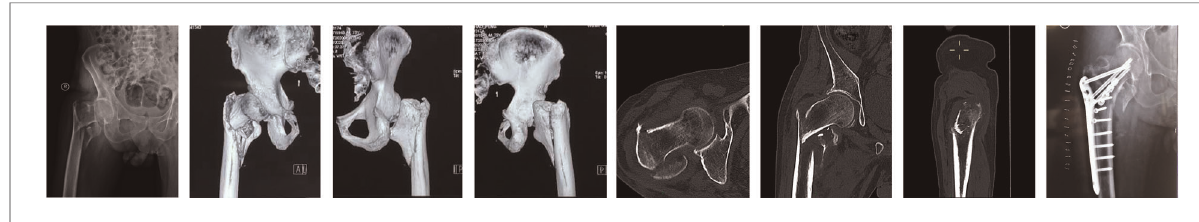
FIGURE 1 Treatment of intertrochanteric fractures with a split greater trochanter using double plates.